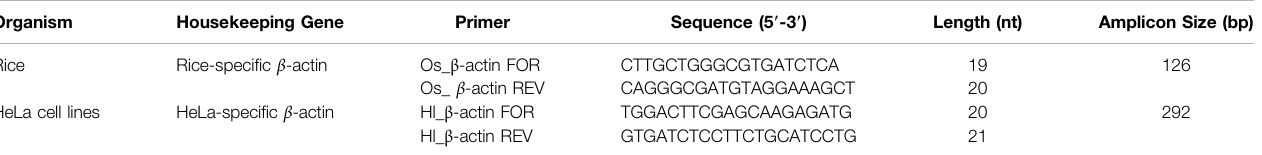
TABLE 2 | Table showing the list of convergent primers used in the study.